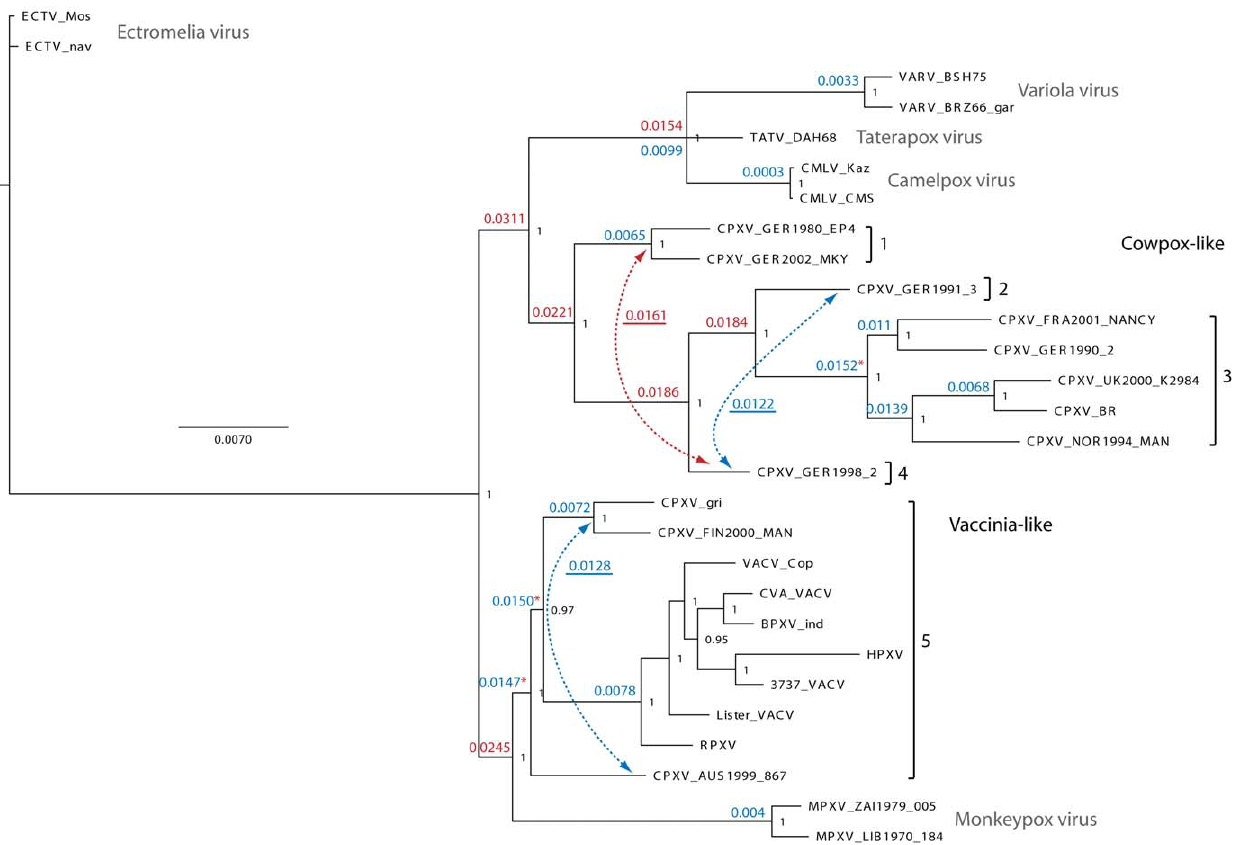
Figure 1. CPXV Phylogeny. The tree search was based on a complete coding region alignment (C23L-B29R) with gapped columns removed (145,177 bp). Posterior probabilities are shown to the right of each node in black. Uncorrected p distance measures were calculated from the matrix and are shown to the left of each node. Red indicates distances greater than or equal to the distance between TATV and the VARV clade (0.0154); blue indicates a distance less than this value. Additional distance measures between nodes and taxa are underlined and designated by dashed arrows. Asterisks indicate distance values at nodes where patristic distance values are above the VARV-TATV threshold and conflict with uncorrected p values. Cowpox-like (groups 1–4) and Vaccinia-like (group 5) clades are indicated to the right. Brackets encompass isolates or groups of isolates where distance measures separate them from their nearest neighbours at least as much as the distance between TATV and VARV. Each of these groups is labelled with a number